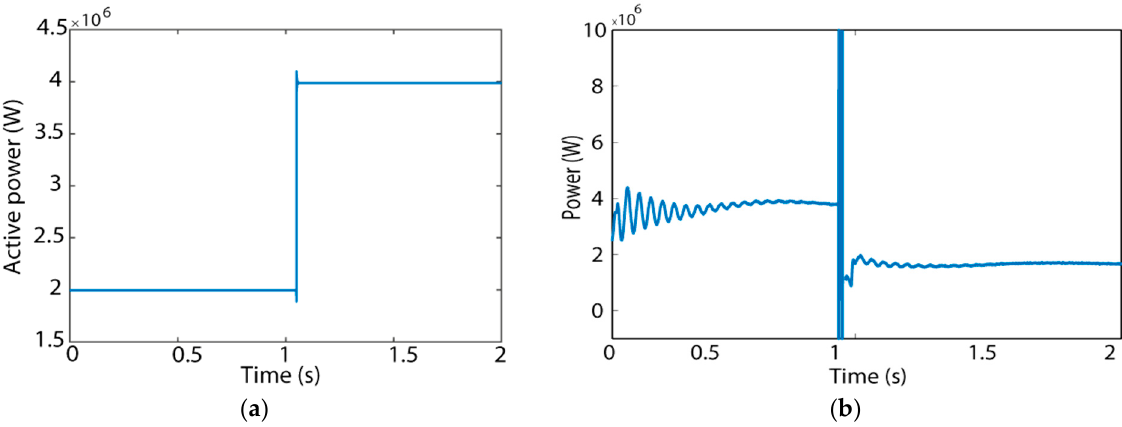
Figure 19. Active power ( a ) of source 1 and ( b ) source 2 during power reconfiguration.